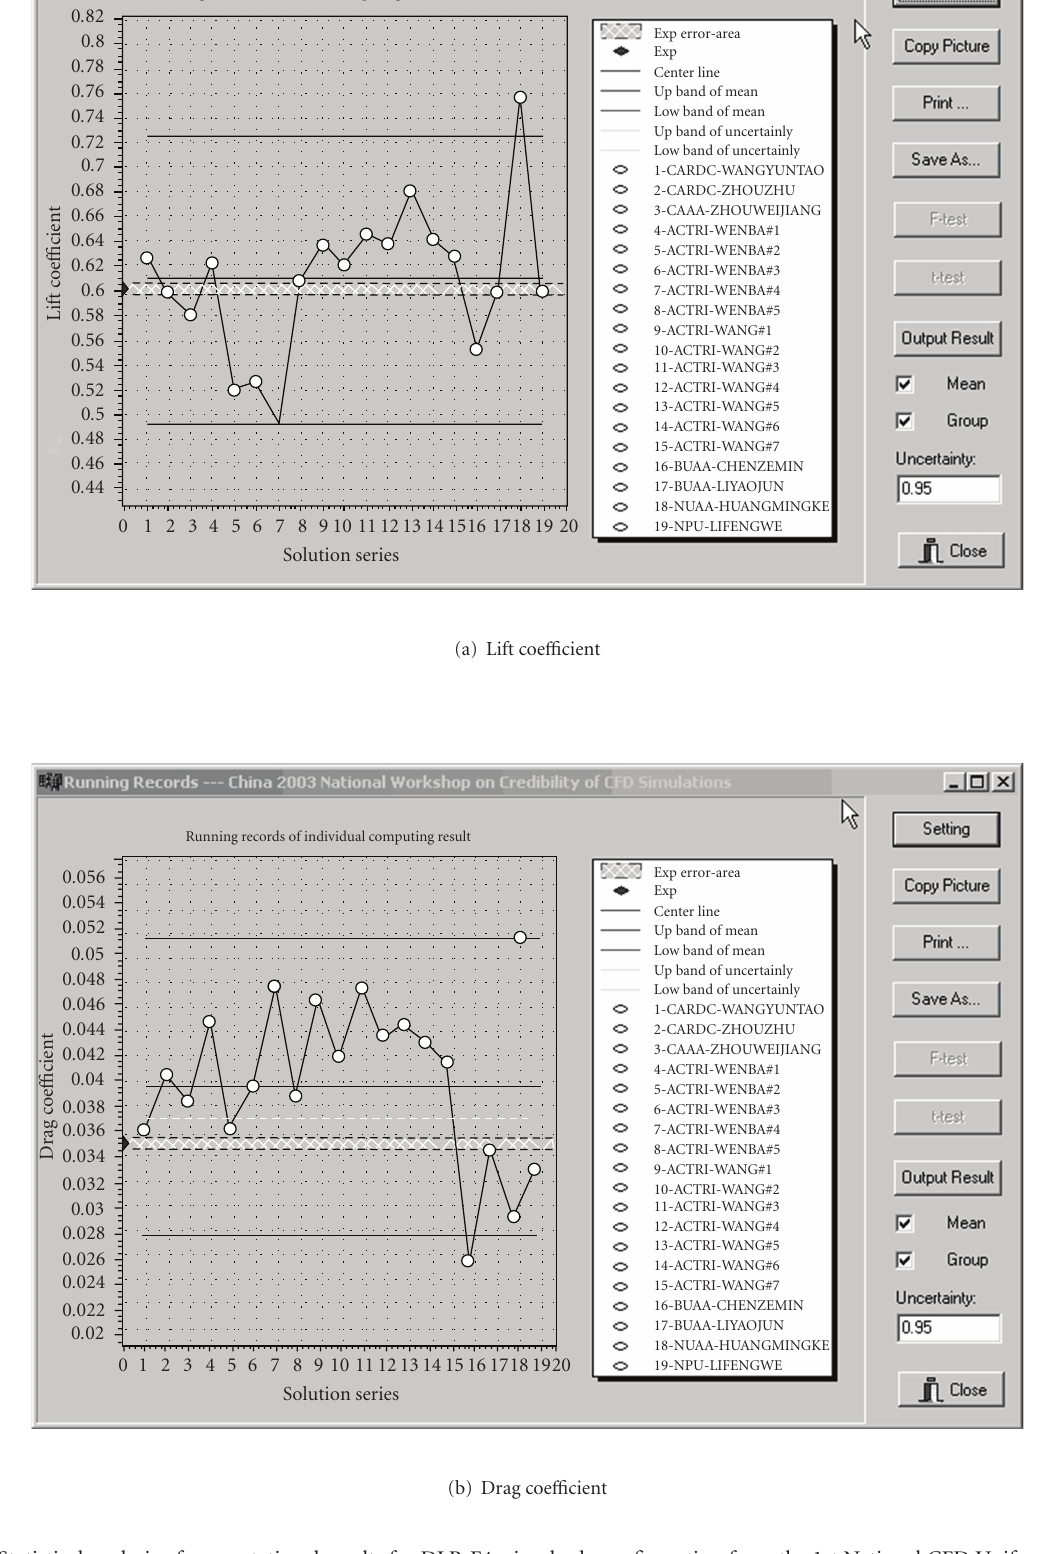
Figure 1: Statistical analysis of computational results for DLR-F4 wing-body configuration from the 1st National CFD Uniform Test Cases Computation